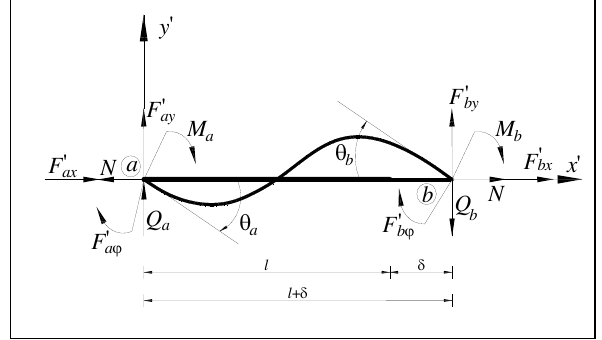
M , a Θ , Θ , δ are de- a b